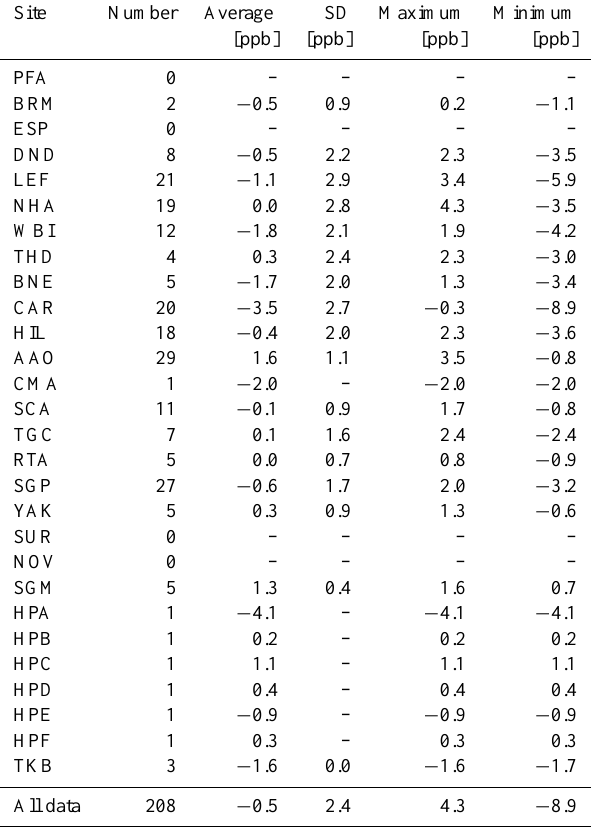
Table 4. Differences between aircraft-based XCH 4 with and with- out application of GOSAT CAK (aircraft-based XCH 4 with CAK minus aircraft-based XCH 4 without CAK) at each site.